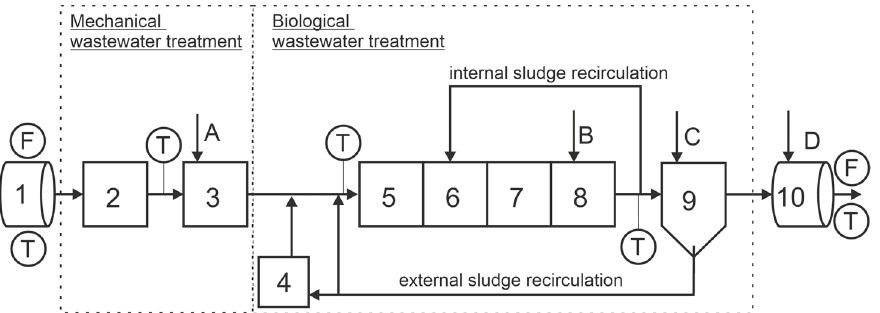
Figure 1. Operational diagram of the Mokrawica WWTP: 1. Wastewater inflow, 2. Screen, 3. Sand